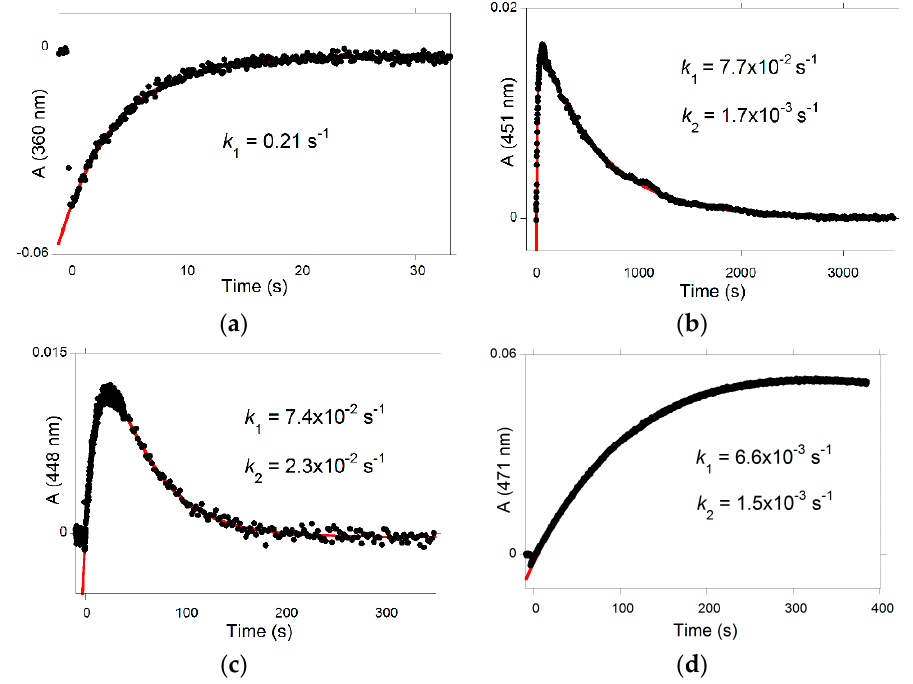
Figure 13. Transient absorption upon a light flash applied to an equilibrated solution of ( a ) P5 at pH = 6.05; ( b ) P4 at pH = 6.06; ( c ) P6 at pH = 5.9; and ( d ) P3 at pH =